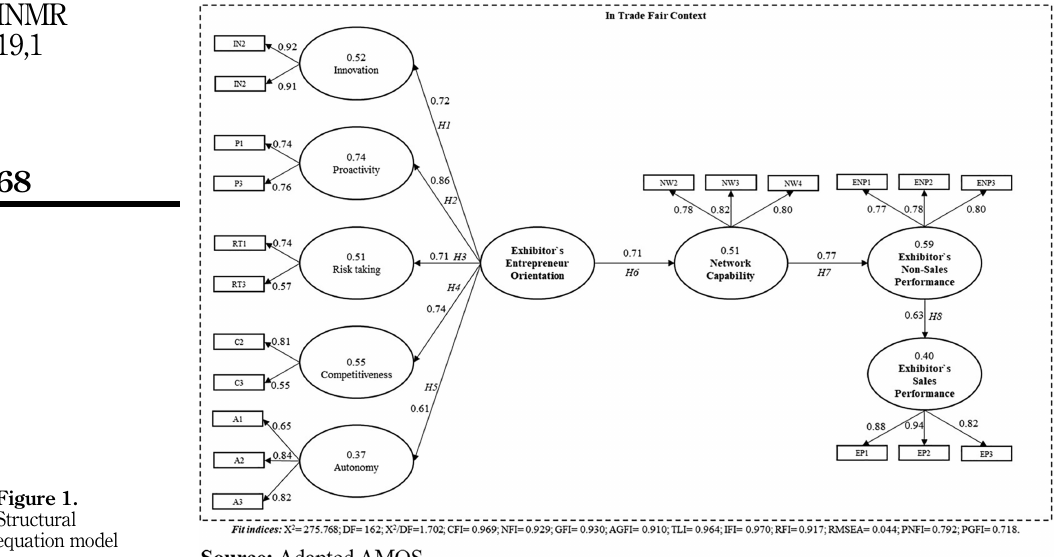
Figure 1. Structural equation